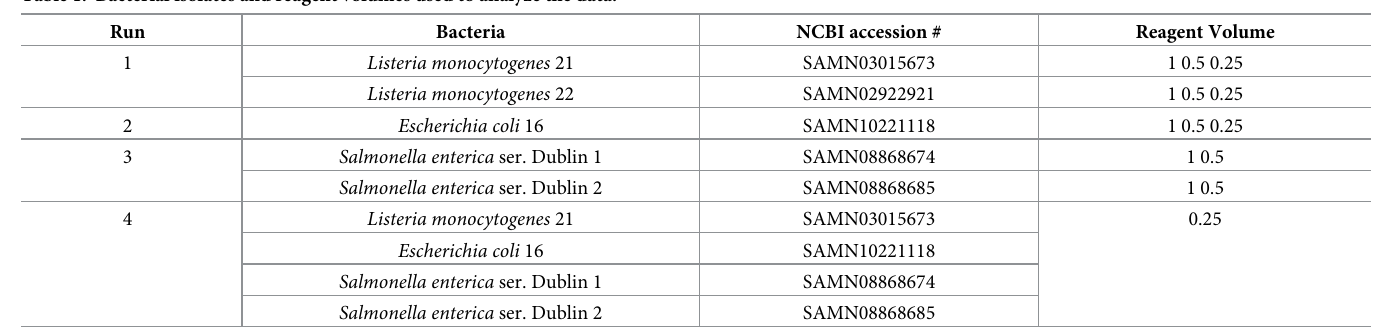
Table 1. Bacterial isolates and reagent volumes used to analyze the